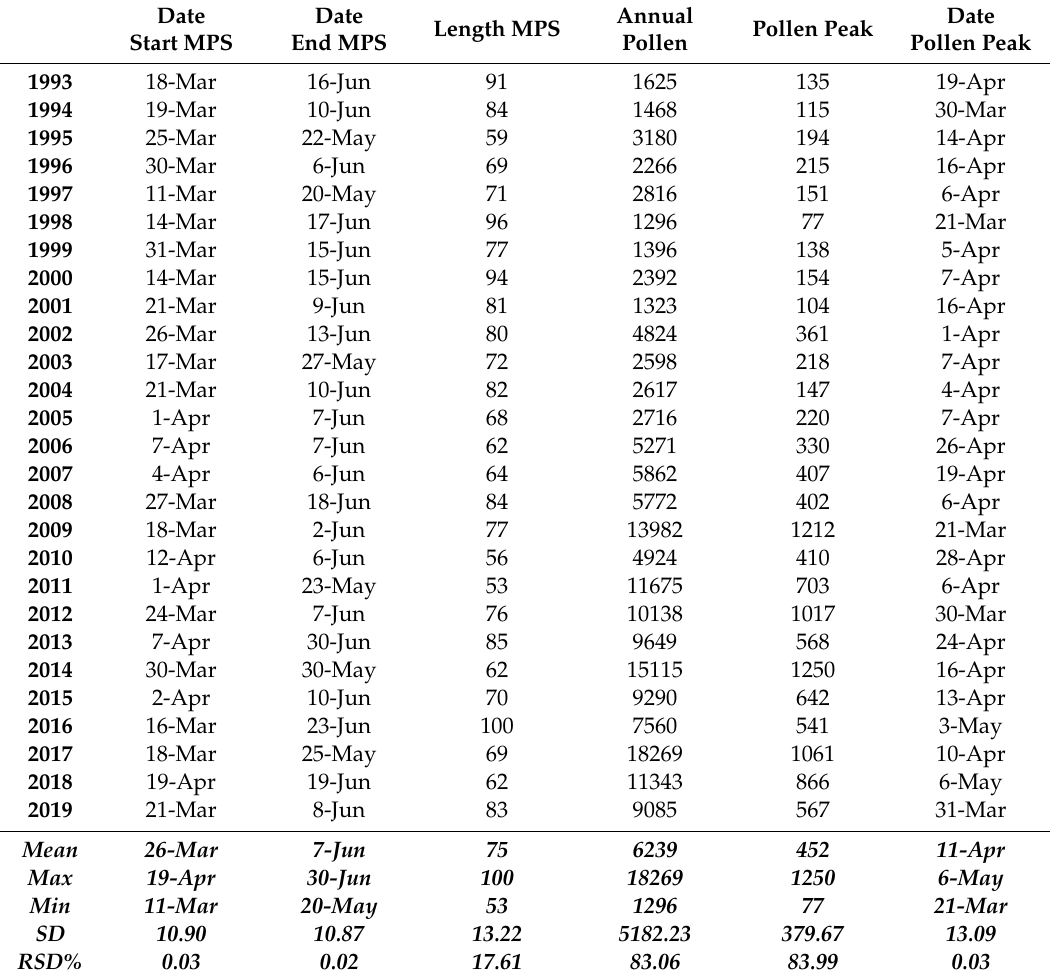
Table 3. Characteristics of the airborne oak MPS during the 27 years of study: start date, end date, length, annual pollen integral (pollen grains), daily pollen peak (pollen / m 3 ) and its date. Average value (Mean), minimum value (Min), maximum value (Max), standard deviation (SD) and relative standard variation in percentage (%RSD) of sampled trees for each species were also